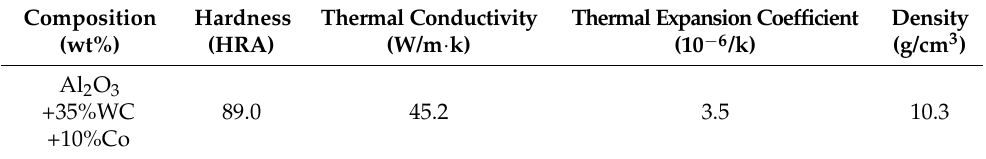
Table 2. Properties of the Al 2 O 3 /WC ceramic.